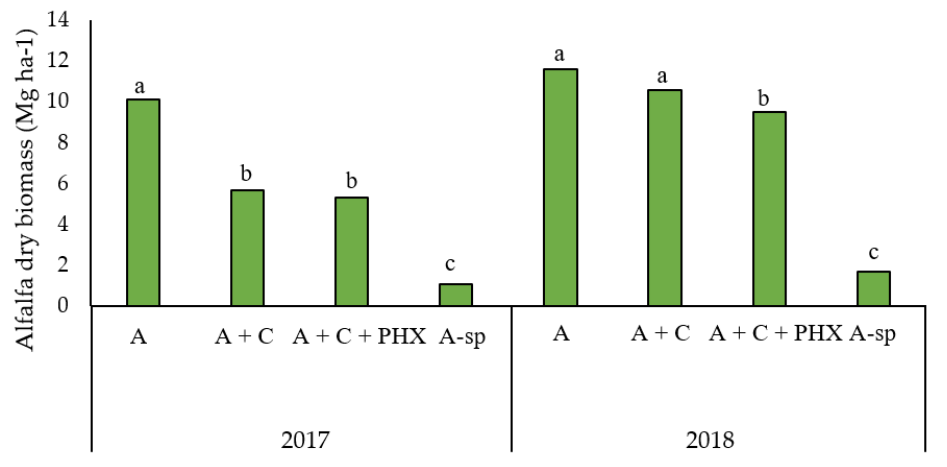
inconsistencies among harvests, the total seasonal biomass yield for the second produc- tion year of alfalfa in 2018 and 2019 was the same across treatments (Figure 3). Mean sea- sonal alfalfa dry matter yield across all the treatments was 9.1 and 6.0 Mg ha −1 in 2018 and 2019, respectively. Table 9. Alfalfa stem height (Ht), growth stage (St), stem density (Stem) at each harvest, and total seasonal dry biomass for second production year of alfalfa in 2018 and 2019. Alfalfa growth stage was measured as per Kalu and Fick (1983).